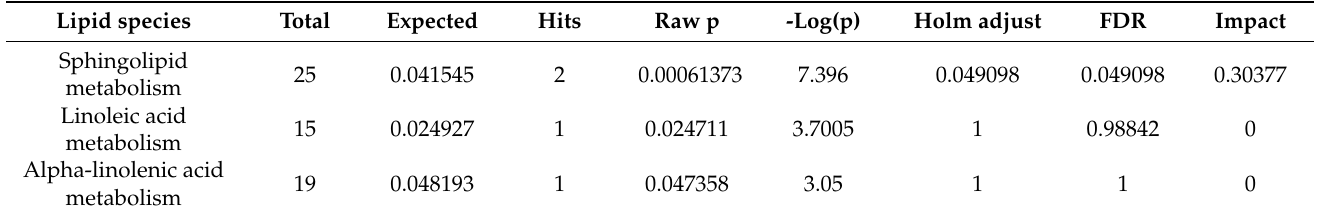
Table 1. Lipid profiles of tumor xenografts. Lipid pathways majorly affected in FTY720-treated mice, significance occurring only for sphingolipid